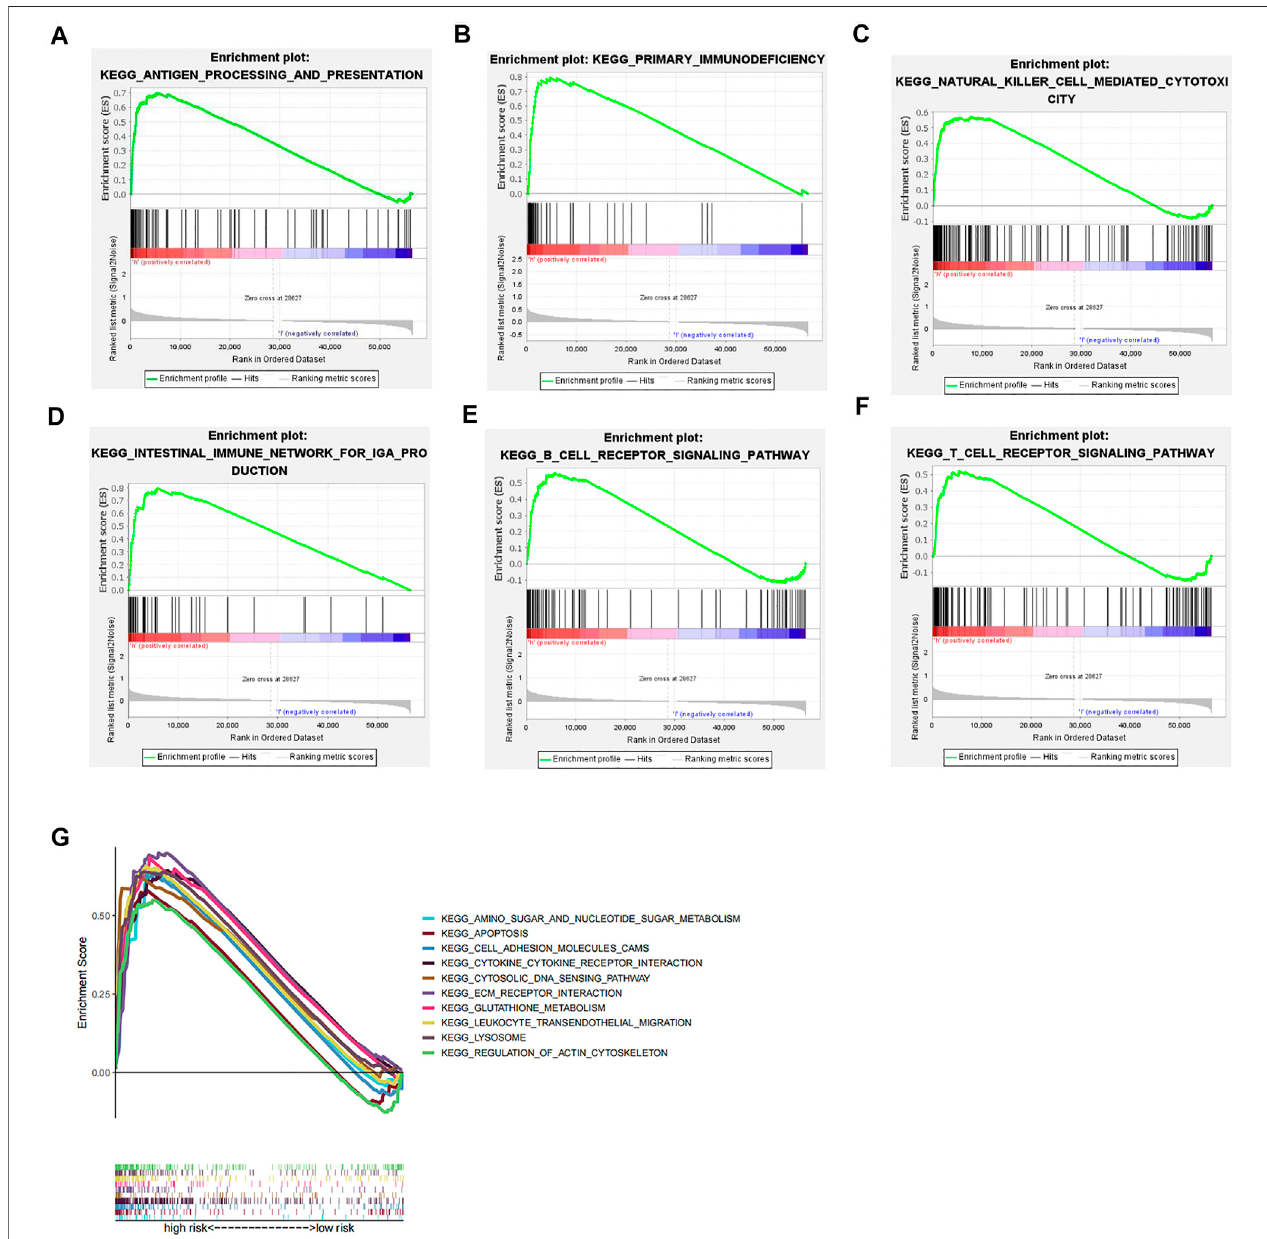
FIGURE 4 | GSEA pathway enrichment analysis. (A – F) Immune-related pathways that are signi fi cantly enriched in the high-risk group. (G) Top ten pathways for GSEA enrichment analysis.